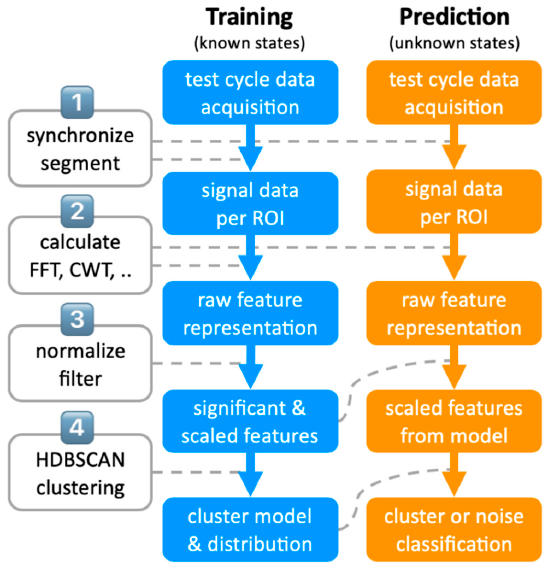
Figure 1. Solution approach for both model training ( blue ) and prediction of test cycle samples in unknown states ( orange ).